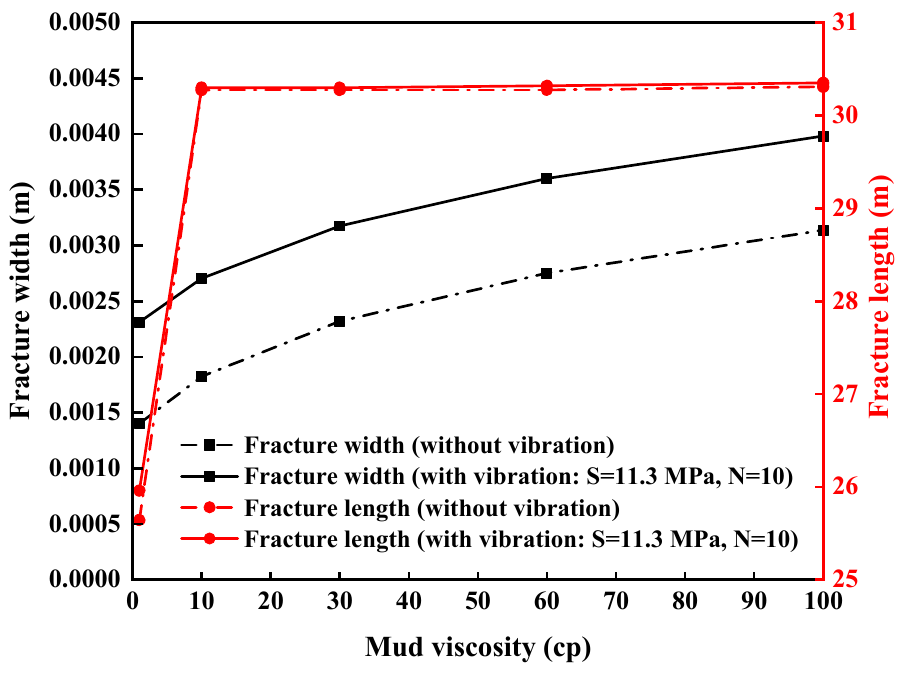
Figure 14. Effect of mud viscosity on fracture width and fracture length with and without vibration cyclic loads.